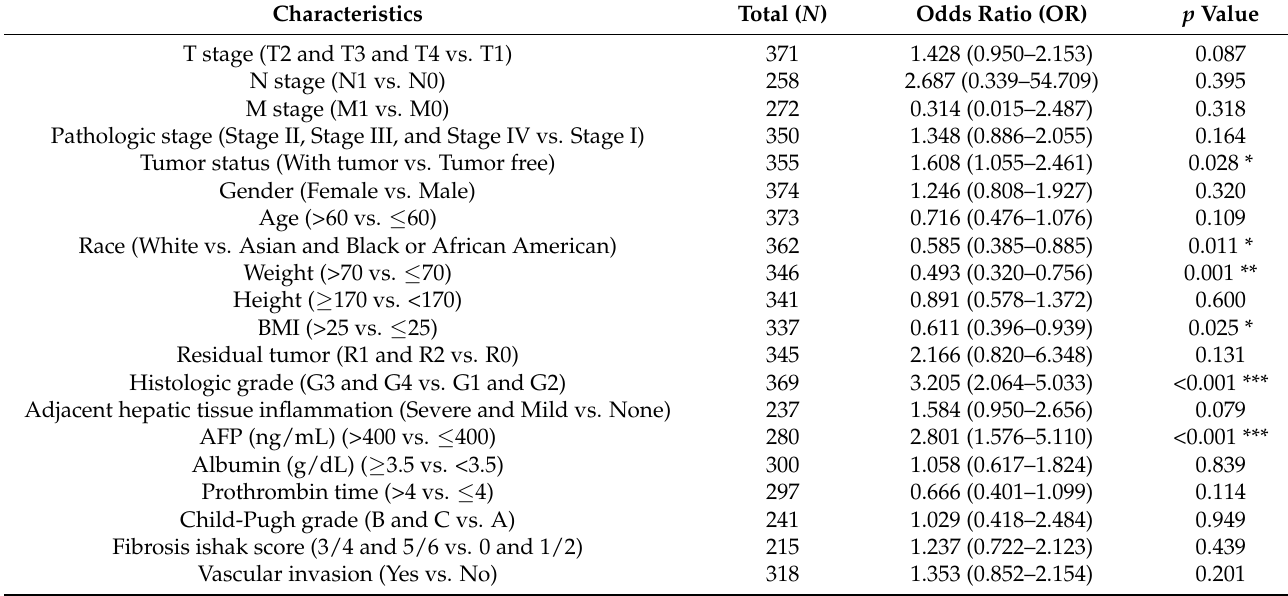
Table 2. Logistics regression analysis for POGK gene